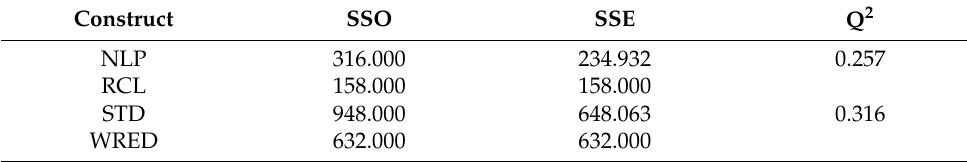
Table 7. The blindfolding test.